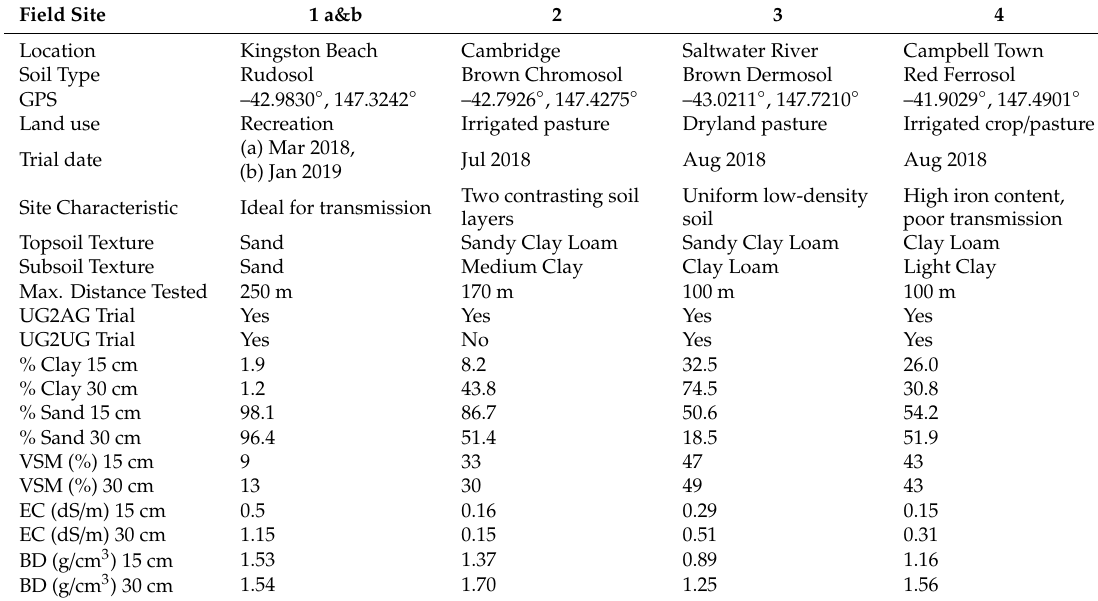
Table 1. Field site characteristics.